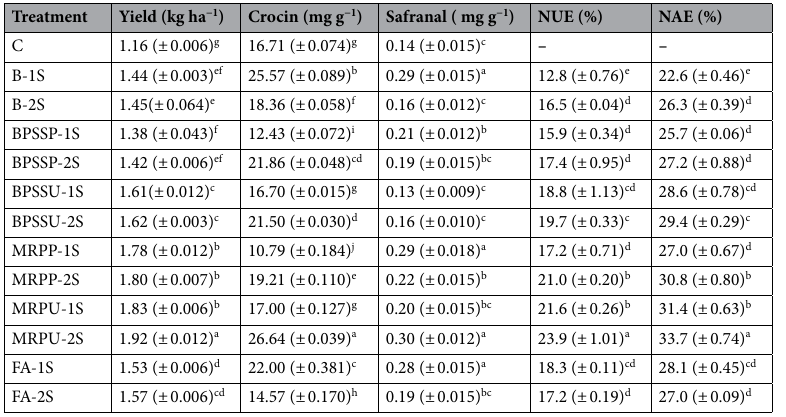
Table 1. NUE, NAE, yield, crocin and safranal content as affected by various N input methods in saffron growing cold humid region of North West Himalayas.